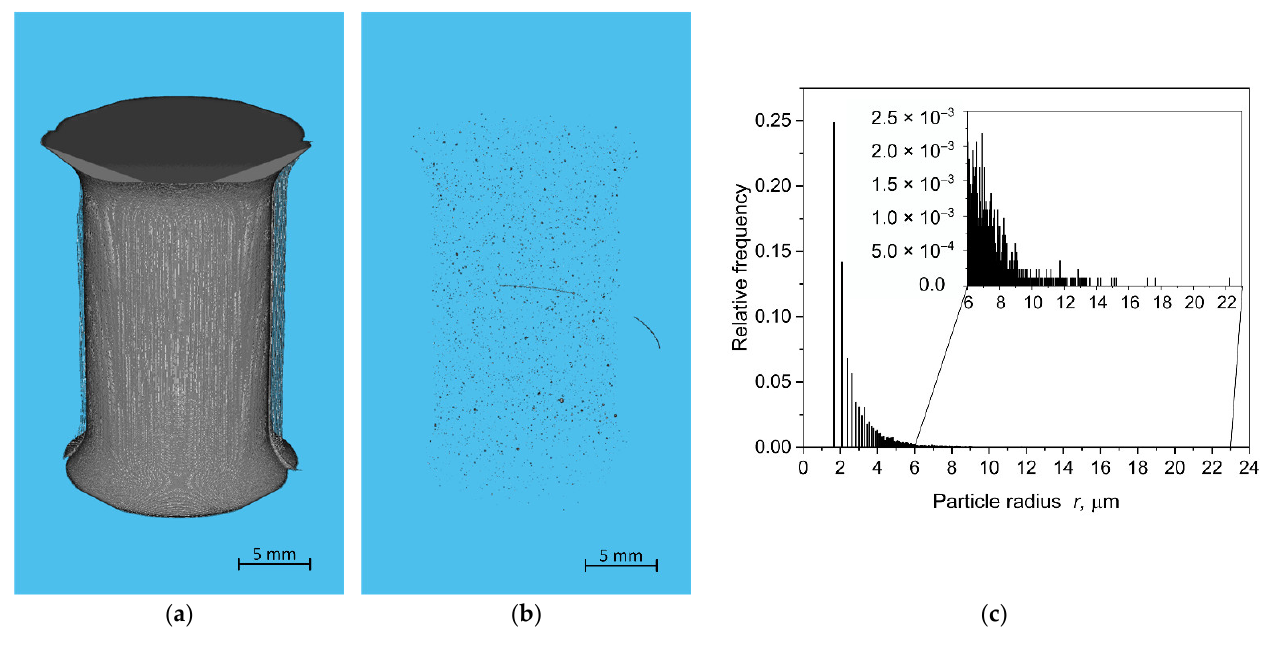
Figure 16. ( a ) Volume reconstruction of an undamaged (i.e., not yet loaded and cycled) axisymmetric dumbbell specimen obtained from μ-CT. ( b ) Cavity distribution in the reconstructed volume obtained from μ-CT with a connectivity equal to 26. ( c ) Particle size distribution considered as the spherical radius of the cavities.